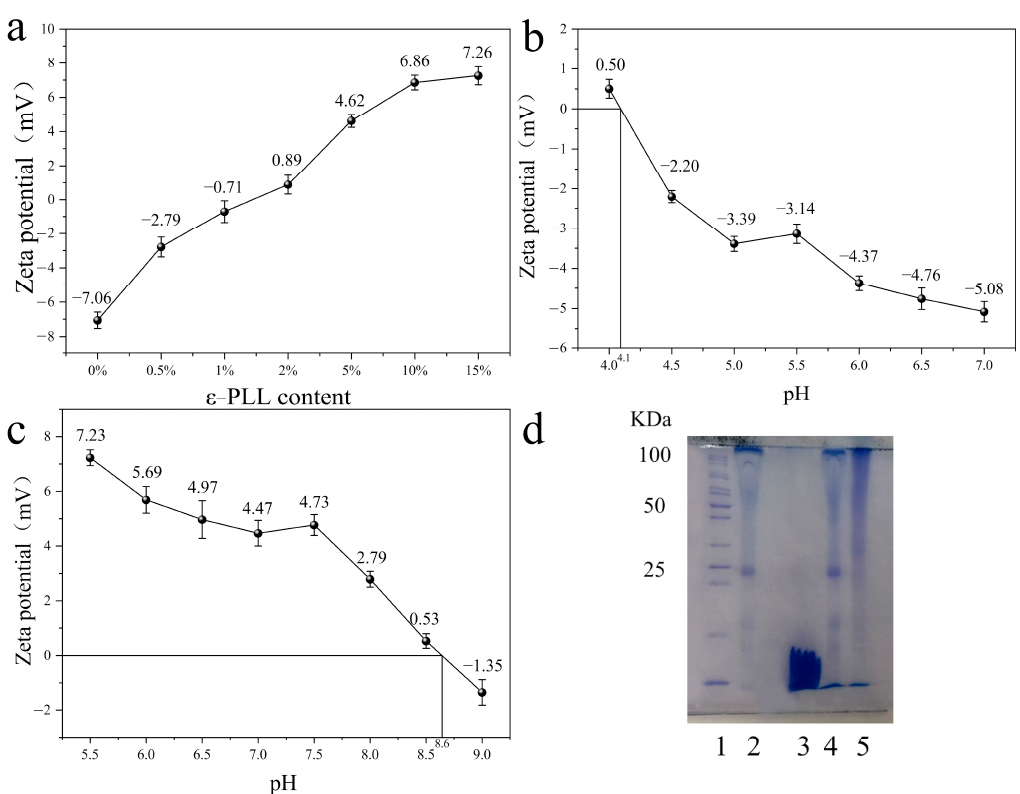
Figure 3. Identification of CSF: ( a ) the zeta potential of SF modified with different ε -PLL content; ( b , c ) Zeta potential of pure SF ( b ), CSF ( c ) under different pH conditions; ( d ) gel electrophoresis of SF before and after cationic polymerization.